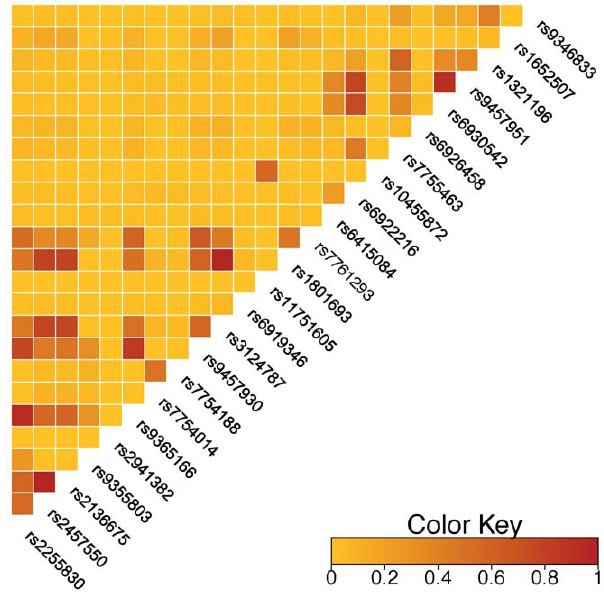
Figure 3. Pairwise linkage disequilibrium measures (r 2 ) for significantly associated SNPs in the JHS African local ancestry subpopulation.